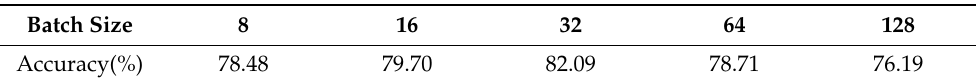
Table 5. Classification performance of the CL–CNN model at different batch sizes with − 5 dB SNR and the sample size of each class being 55.